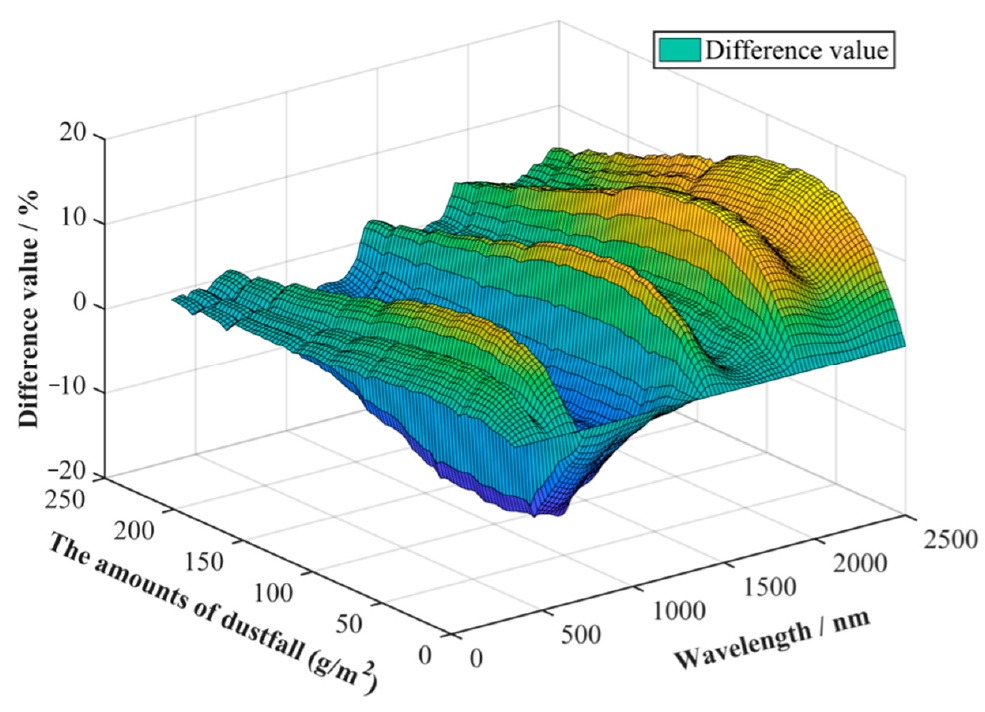
Figure 6. The difference between the simulated spectral value and the measured spectrum.